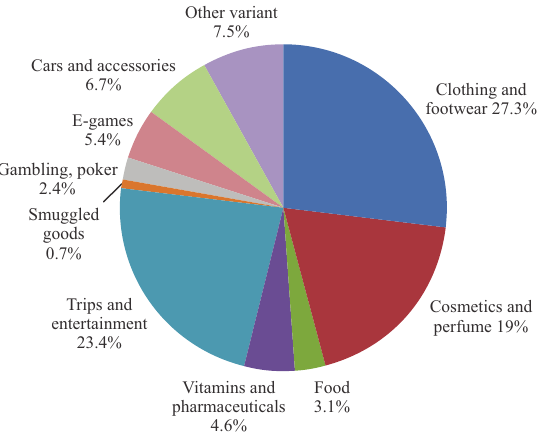
Fig. 1. The categories of the goods/services acquired via the channels of digital shadow consumption, percent (compiled by the authors with reference to the results of the survey)